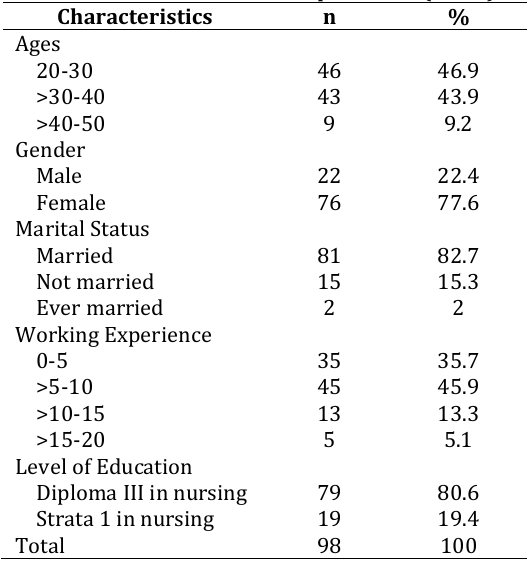
Table 1. Characteristics of respondents